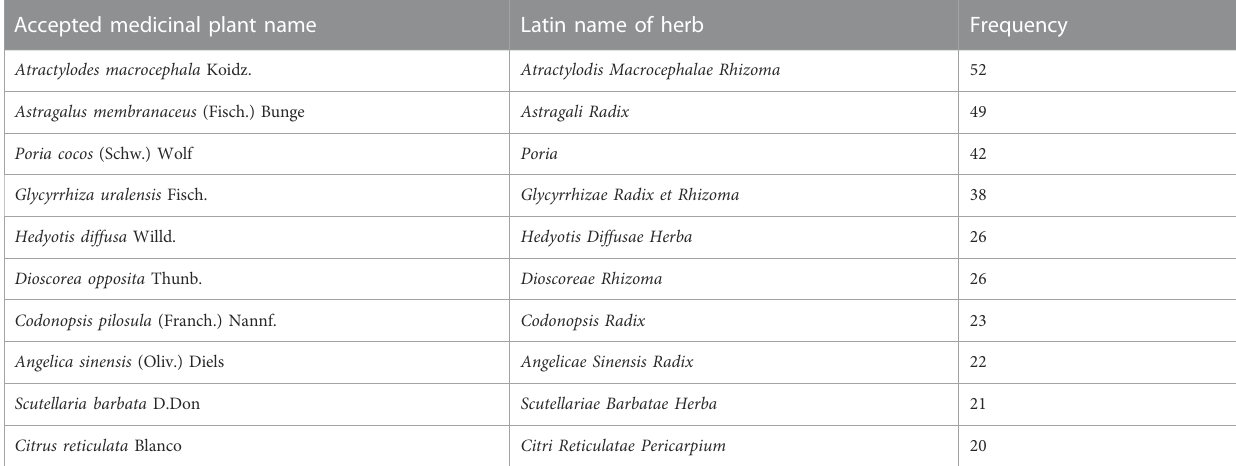
TABLE 1 The number of studies utilizing prescriptions containing Coicis Semen for the management of malignant tumors of the female reproductive